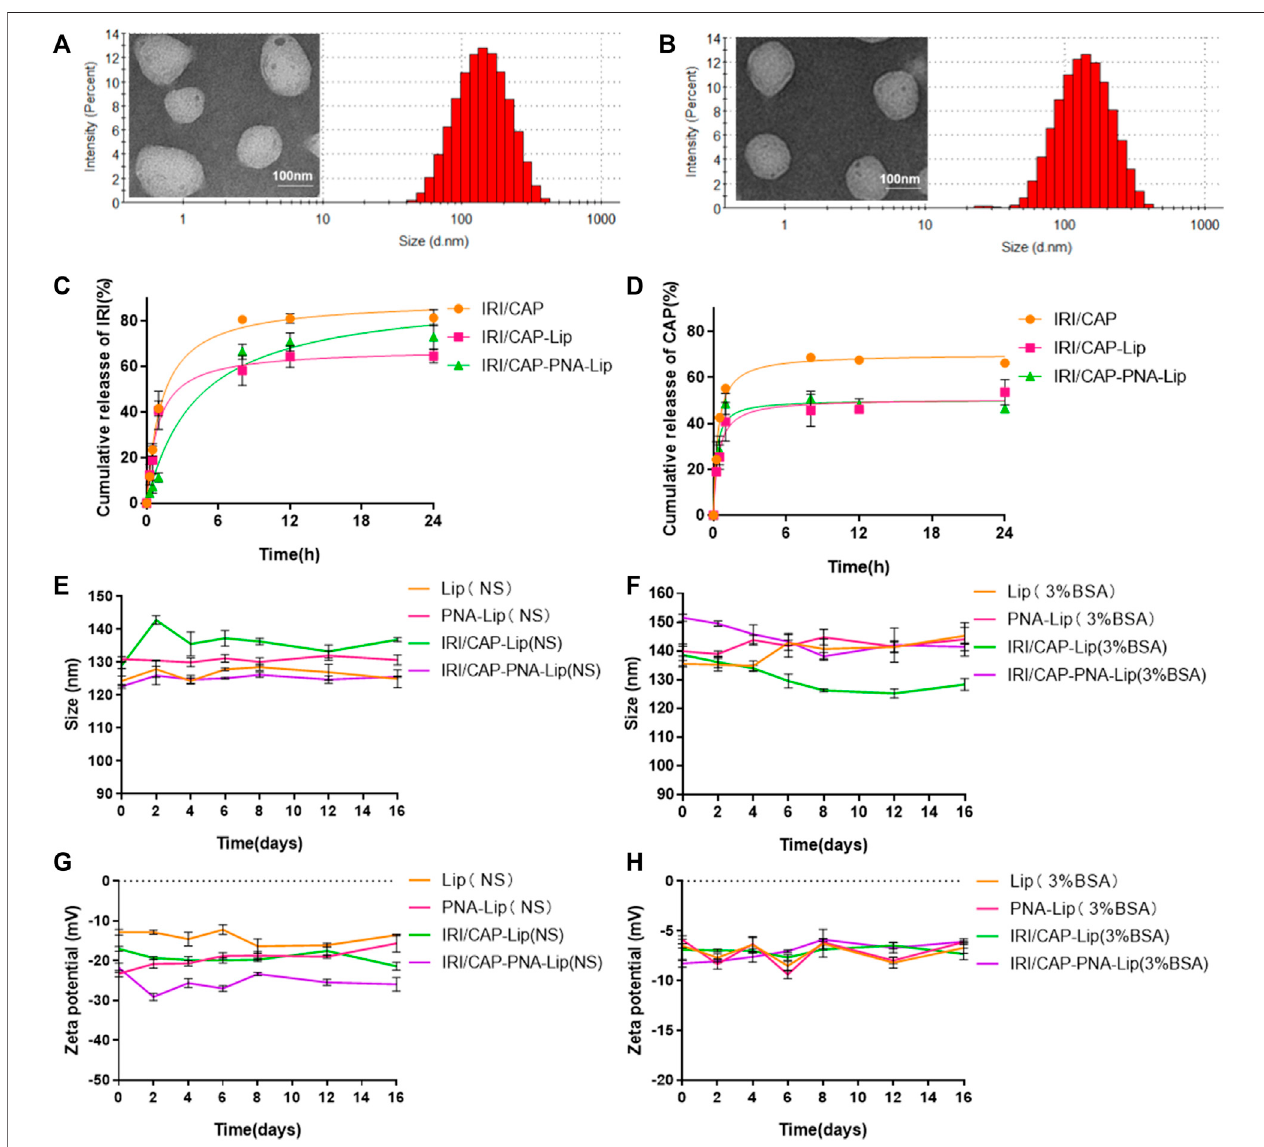
FIGURE3| Analysisofthedrug release capacity and stability ofdifferenttypes ofdrug-loadedliposomes. (A,B) Particle sizehistograms and transmission electron microscopy(TEMik)imagesofIRI/CAP-LipsandIRI/CAP-PNA-Lips. (C) Cumulativedrugreleasepro fi lesofIRI-loadedliposomesinPBSat37 ° C. (D) Cumulativerelease curves of CAP-loaded liposomes in PBS at 37 ° C. (E,F) Folding graphs of particle size changes of different types of liposomes stored in saline or 3% BSA at 4 ° C for 16 days. (G,H) Folding graphs of potential changes of different types of liposomes stored in saline or 3% BSA at 4 ° C for 16 days. The data are presented as the mean ± SD ( n = 3).